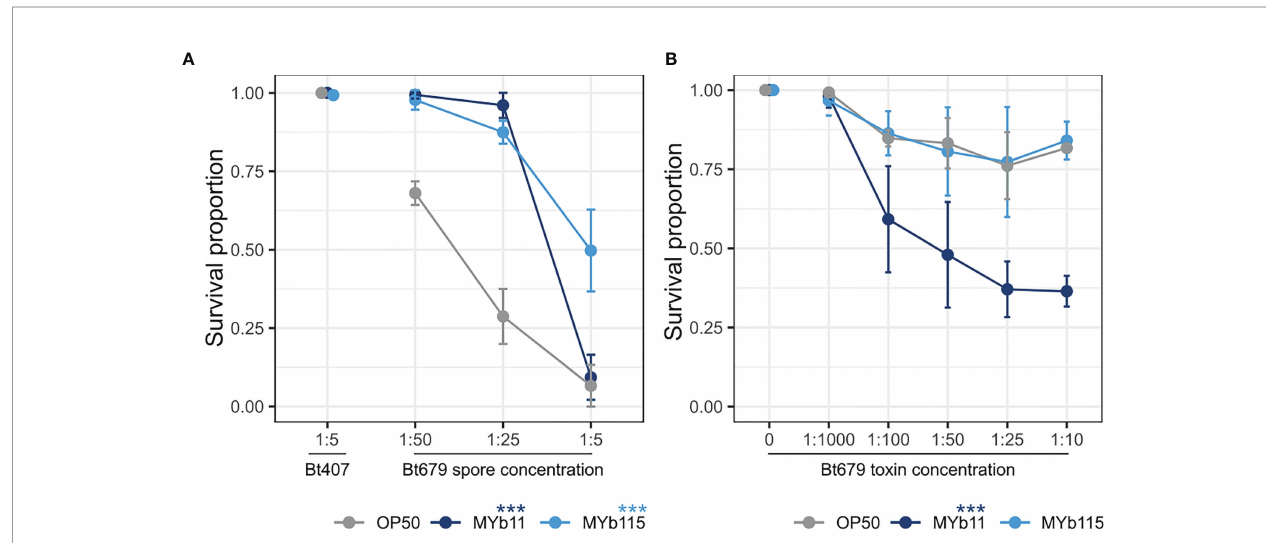
FIGURE 3 | MYb11 and MYb115 protect C. elegans from infection with B. thuringiensis Bt679, but MYb11 increases susceptibility to puri fi ed Bt679 toxins. (A, B) Survival proportion of C. elegans N2 on different concentrations of B. thuringiensis Bt679 (A) spore solution and (B) puri fi ed toxins (containing Cry21Aa3 and Cry14Aa2) mixed with each of the microbiota isolates (MYb11 or MYb115), or OP50 as a control 24 hours post infection. B. thuringiensis strain Bt407 (mixed with each of the microbiota isolates independently or OP50) was used as a non-pathogen control in the infection experiments with Bt spores. Data are representative of three independent runs (see Supplementary Table ). Error bars denote the range of the median of survival proportions of four biological replicates (n = 4), each containing at least 30 worms per treatment condition. Statistical analyses were performed using the GLM framework and Bonferroni correction for multiple testing with the OP50 control treatment group. P values are considered signi fi cant and denoted with asterisks according to *** p <